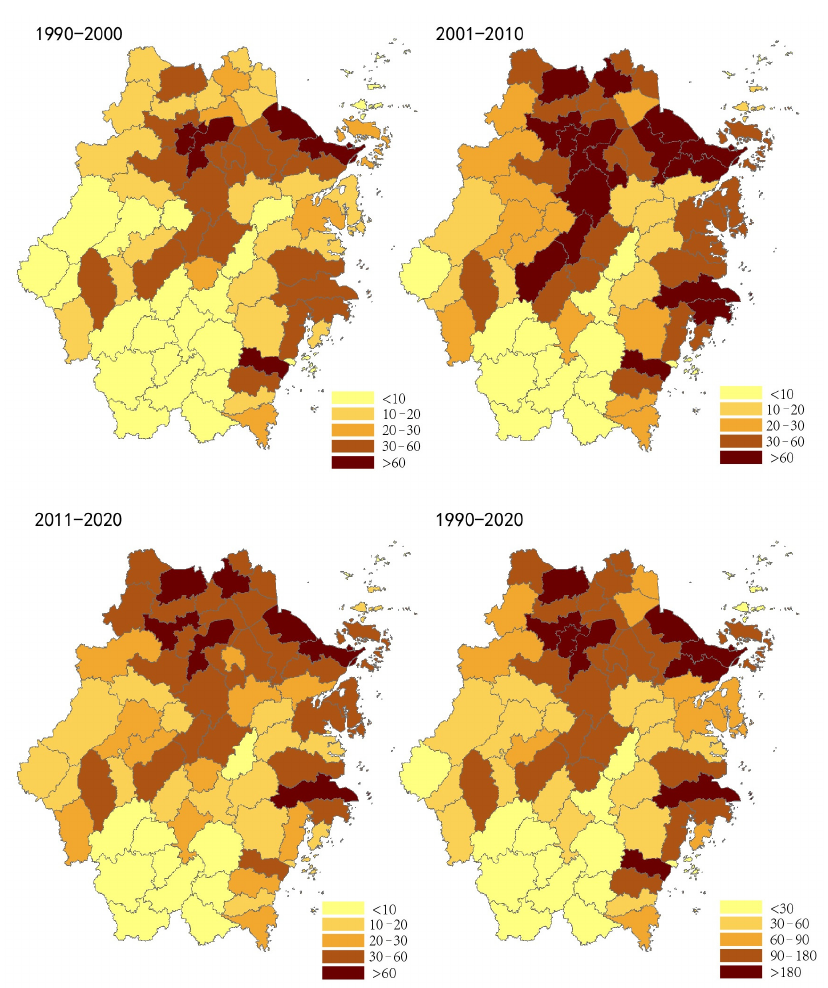
Figure 6. The built-up area expansion of counties in Zhejiang Province from 1990 to 2020 (km 2 Figure 6. The built ‐ up area expansion of counties in Zhejiang Province from 1990 to 2020 (km 2 ).